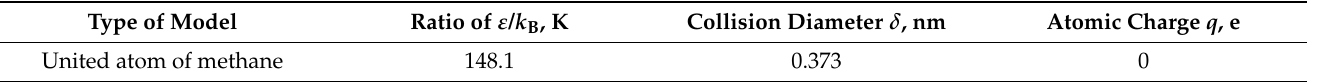
Table 1. TraPPE potential energy parameters for united atom of methane.